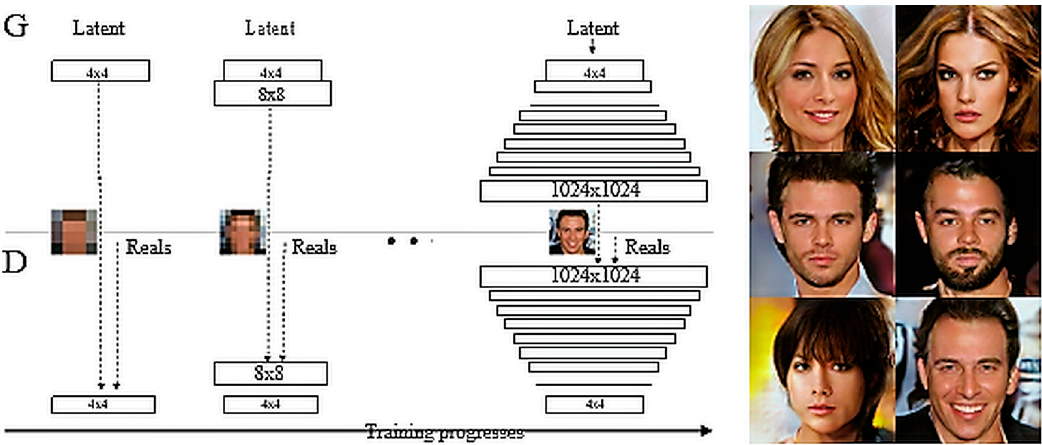
Figure 24. Improvement of G and D values gradually through the training process.